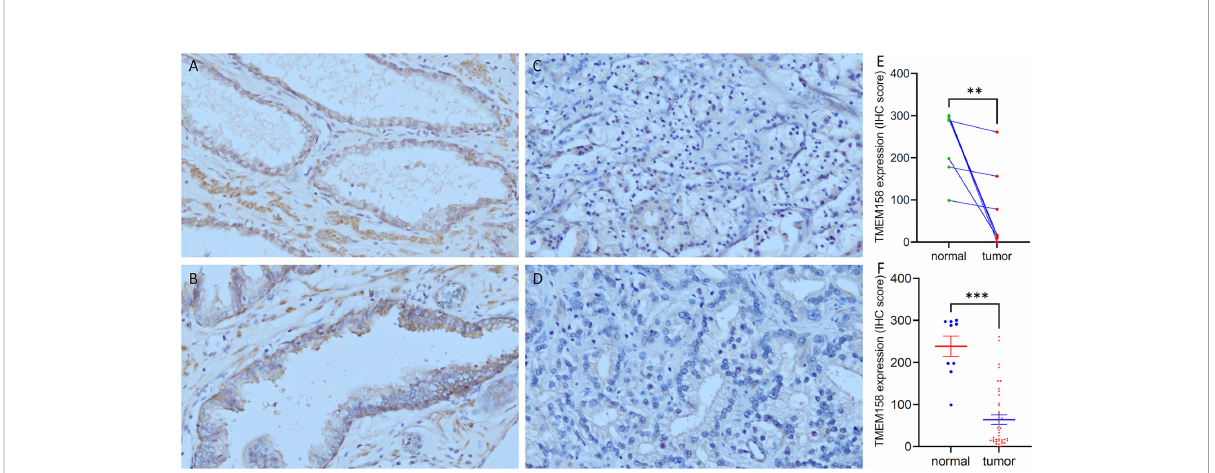
FIGURE 2 TMEM158 protein expression is decreased in prostate cancer tissues. TMEM158 protein expression was examined in prostate cancer tissues with an immunohistochemistry approach, as described in our recent publication (30). Representative microscopic images were taken from benign prostatic tissues (A – B) and malignant prostate tissues (C – D) . Magni fi cation x 200. Semi-quantitative data (MEAN and SEM) of the immunosignals were shown for the pairwise comparison (E) and group cohort comparison (F) . The asterisk indicates a signi fi cant difference (Student t -test, **p < 0.001, ***p <